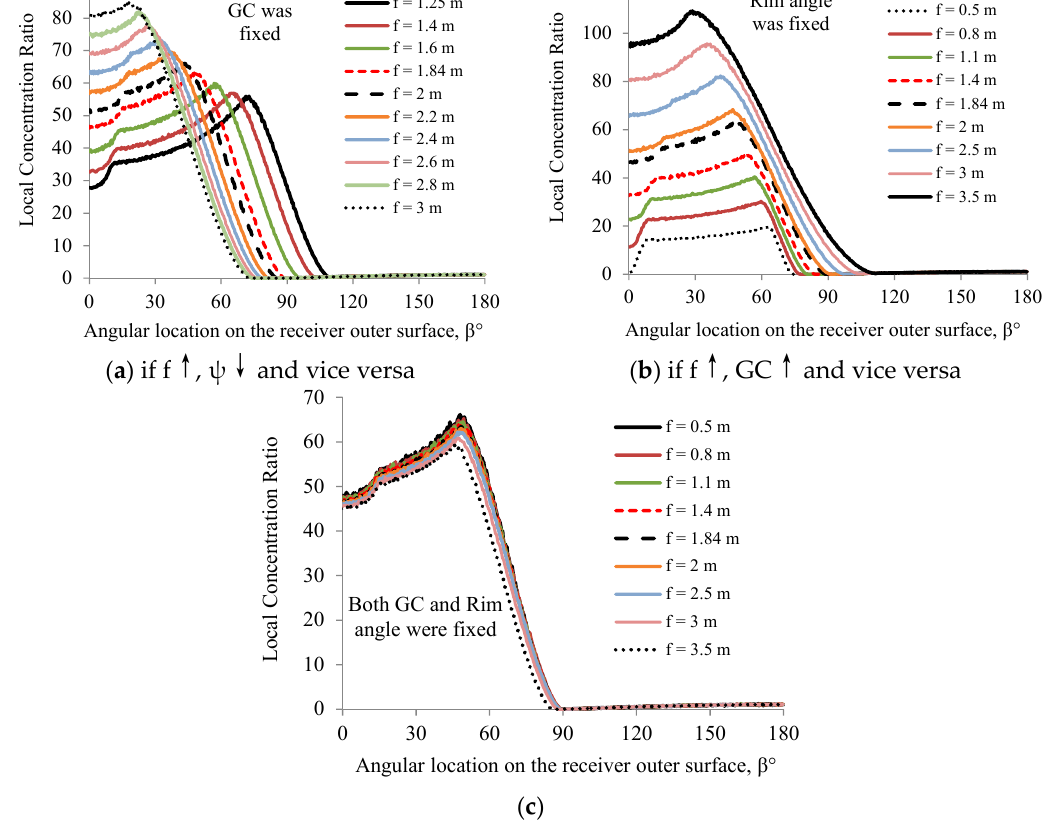
Figure 9. Effect of mirror variations in terms of their focal length, f, on local oncentration ratio profile of a PTC for: ( a ) Fixed Geometric Concentration (GC). The receiver outer diameter and the mirror aperture width are fixed. So a mirror of a larger focal length has a smaller rim angle and vice; ( b ) Fixed rim angle, ψ . As the receiver outer diameter and rim angle are fixed, a mirror of a larger focal length has an larger aperture width, and so a larger GC, and ( c ) fixed GC and rim angle.